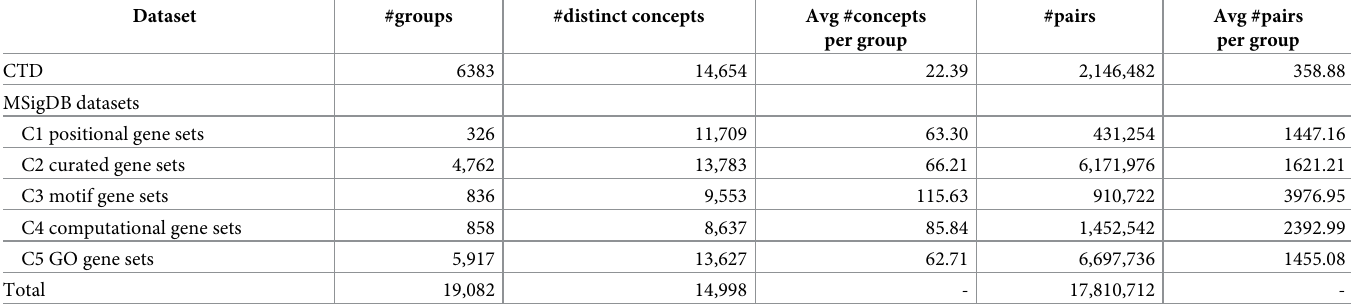
Table 3. The statistics of datasets in intrinsic evaluation tasks. There are six datasets in total. #groups: the number of groups in a dataset. Each group has a related set and an unrelated set of genes based on drug-gene interactions provided by CTD or gene sets provided by MSIGDB. #distinct concepts: the total number of distinct genes in a dataset. Avg #concepts per group: the average of number of genes in a group; note that one gene may be in multiple groups. #pairs: the total number of pairs in a data- set. Avg #pairs per group: the average of the number of pairs per group.